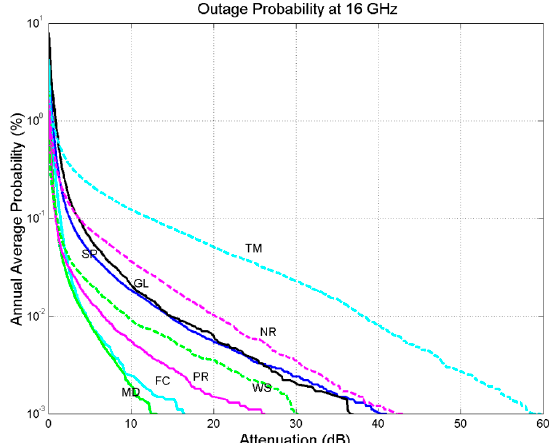
Figure 1. Annual average probability P ( A ) (%) of exceeding the rain attenuation A (dB) indicated in abscissa, at the indicated sites: Spino d’Adda (SP, blue continuous line); Gera Lario (GL, black continuous line); Fucino (FC, cyan continuous line); Madrid (MD, green continuous line); Prague (PR, magenta continuous line); Tampa (TM, cyan dashed line); Norman (NR, magenta dashed line); White Sands (WS, green dashed line), at 16 GHz in zenith paths. When the power margin in the zenith radio-links of the GeoSurf satellite constellations is equal to (cid:1827) (dB), (cid:1842)((cid:1827)) represents the out- age probability.